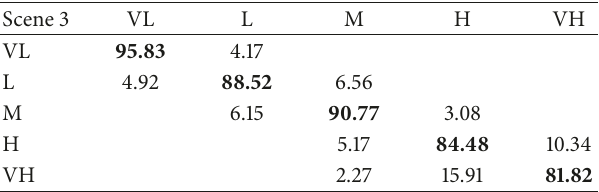
Table 7: The accuracy of our method on scene 3 (%). Scene 3